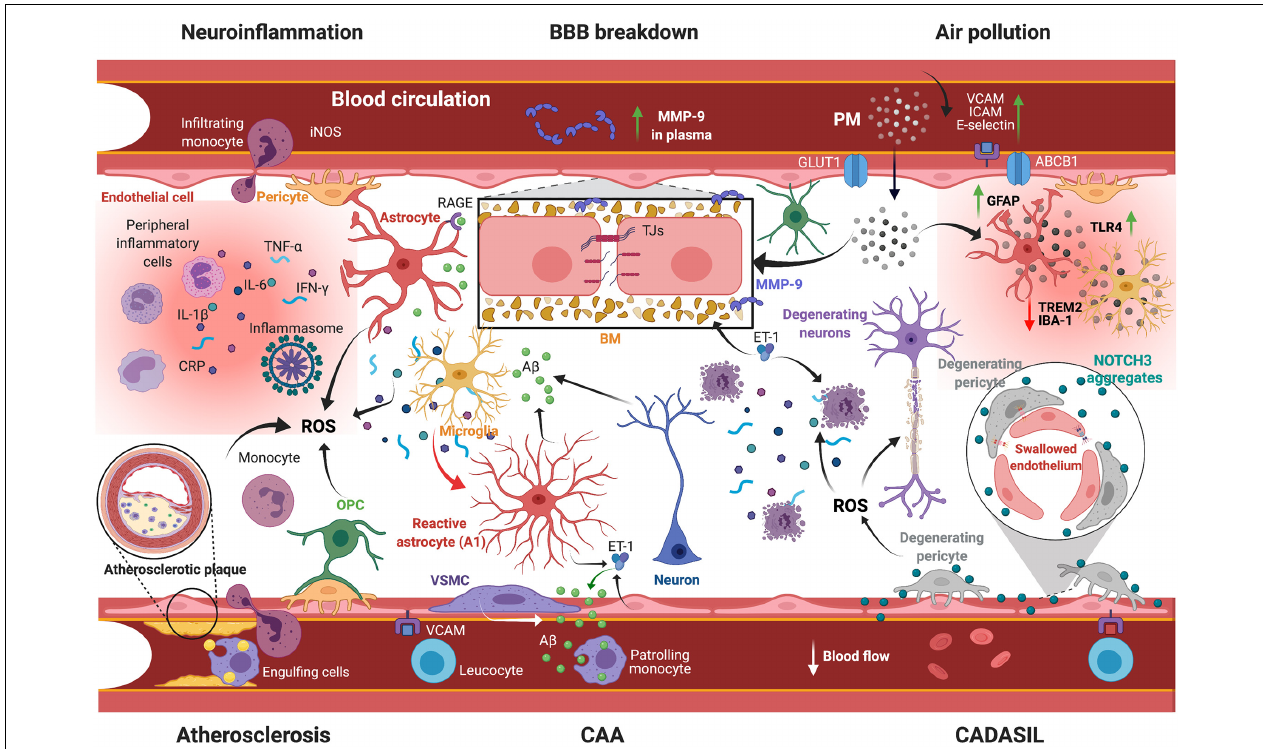
FIGURE 2 | Scheme illustrating the mechanisms underlying VaD pathobiology. Several vascular risk factors are implicated in orchestrating pathological responses leading to VaD: (i) BBB breakdown involves the impairment of TJs and degradation of BM formed by ECM proteins via MMP-9 activity. Plasma MMP-9 levels constitute an effective prognostic marker for a poor neurological outcome; (ii) Post-stroke neuroinflammation comprises extravasation of peripheral immune cells and secretion of inflammatory mediators (e.g., CRP, TNF- α , IL-1 β , IL-6, IFN- γ ), as well as ROS generation and glial activation, accompanied by cerebral A β aggregation; (iii) Atherosclerosis comprises the accumulation of lipids and the calcification of immune cells into the intima, leading to vessel occlusion and hypoperfusion. This condition is associated with the generation of ROS that causes chronic inflammation; (iv) CAA is associated with the degeneration of VSMCs and vascular A β aggregation due to impaired clearance; (v) CADASIL is associated with NOTCH3 aggregation, causing endothelial cell swelling and pericyte degeneration and subsequently CBF impairment; and (vi) Exposure to air pollution, which implies PM infiltration into the brain, exacerbates BBB breakdown and neuroinflammation. VaD, vascular dementia; BBB, blood-brain barrier; TJs, tight junctions; BM, basement membrane; ECM, extracellular matrix proteins; MMP-9, matrix metalloproteinase-9; CRP, C-reactive protein; TNF- α , tumor necrosis factor- α ; IL-1 β /6, interleukin-1 β /6; IFN- γ , interferon- γ ; ROS, reactive oxygen species; A β , amyloid- β ; CAA, cerebral amyloid angiopathy; VSMCs, vascular smooth muscle cell; CADASIL, cerebral autosomal dominant arteriopathy with subcortical infarcts and leukoencephalopathy; NOTCH3, neurogenic locus notch homolog protein-3; CBF, cerebral blood flow; PM, particulate matter; GLUT1, glucose transporter-1; ABCB1, ATP binding cassette subfamily B member-1; VCAM, vascular cell adhesion protein; ICAM, intercellular adhesion molecule; TLR4, Toll like receptor-4; TREM2, triggering receptor expressed on myeloid cells-2; GFAP, glial fibrillary acidic protein; RAGE, receptor for advanced glycation endproducts; ET-1, endothelin-1; iNOS, inducible nitric oxide synthase; OPC, oligodendrocyte progenitor cell. Created with